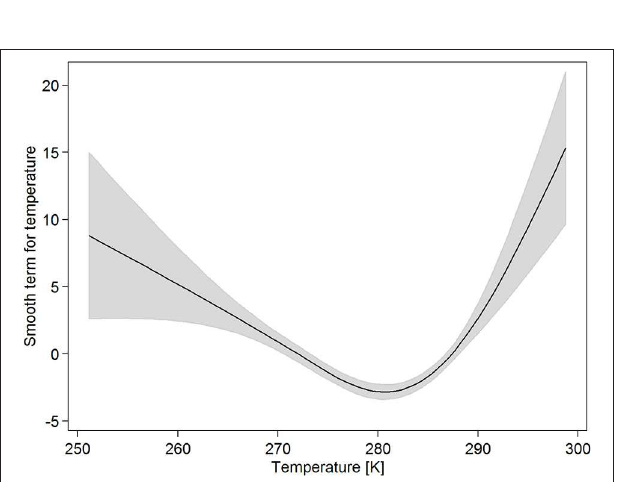
FIGURE 5 | Effect of GLRD upon expected ambient O 3 concentration, BKR